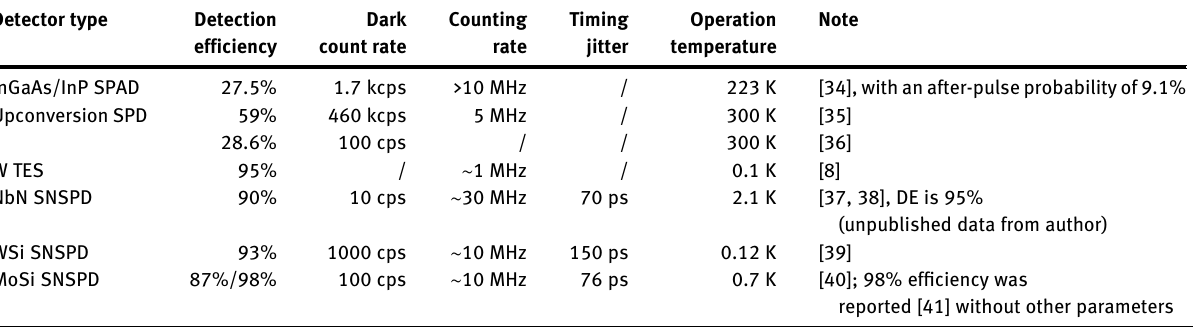
Table  : State-of-the-art performance of different SPDs at a wavelength of  nm for quantum information. Detector